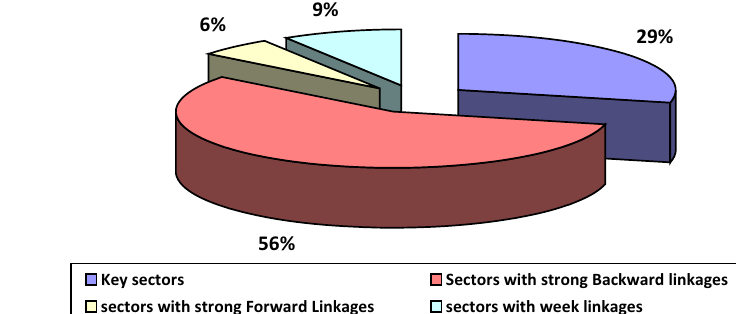
Figure 5. Share of different sectoral groups in the fi scal stimulus